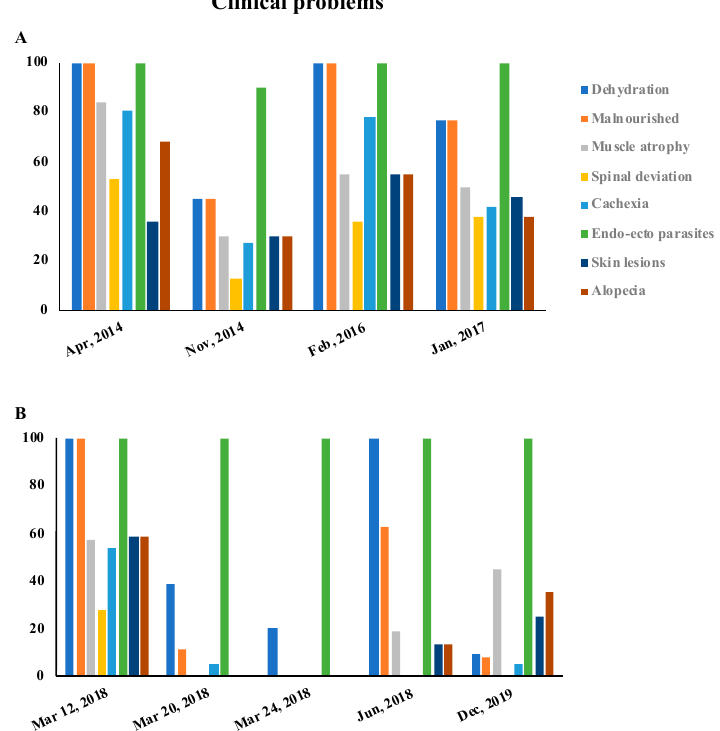
Figure 2. The graphs show the percentages of clinical problems encountered in dogs subject to seizures. ( A ): the data refer to the seizures from April 2014 to January 2017; ( B ): the data refer to the seizures carried out from March 2018 to December 2019.